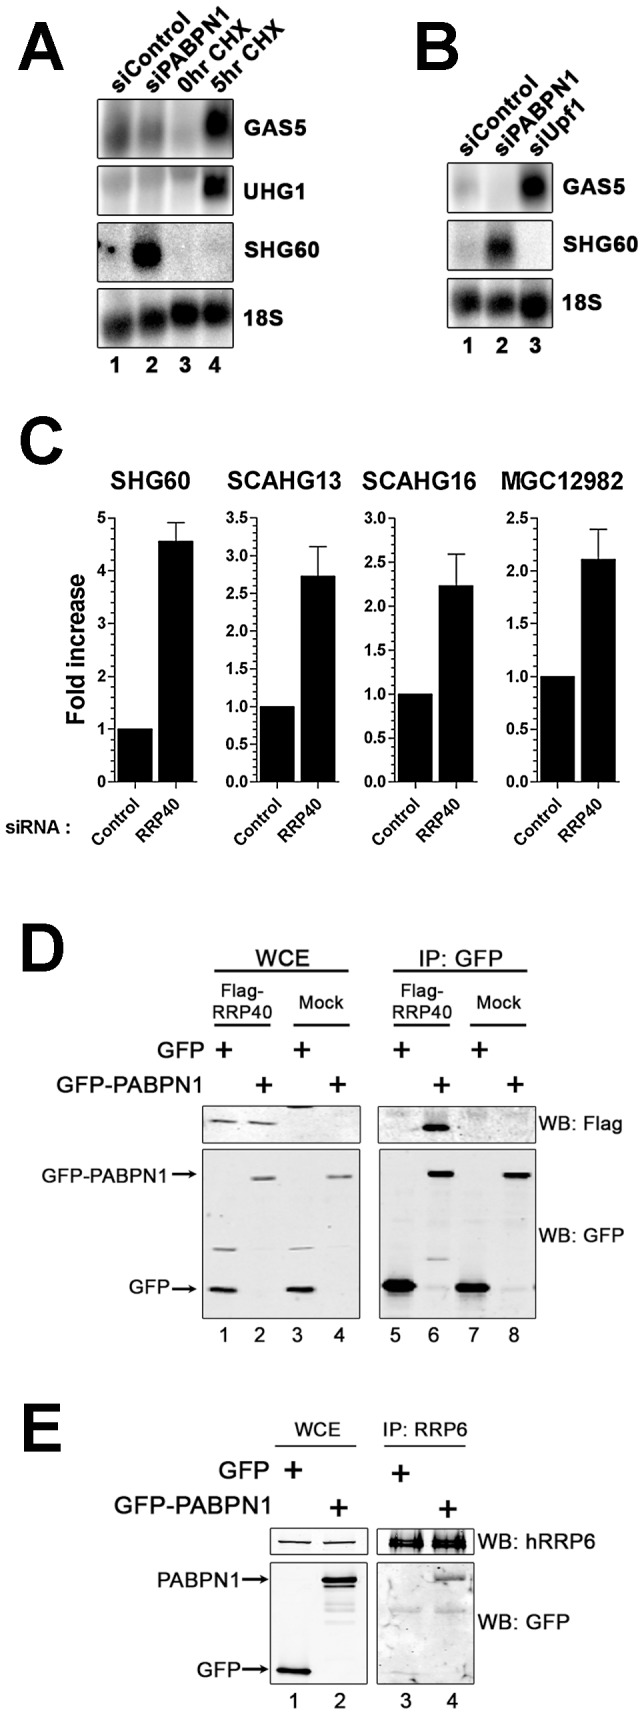
The RNA exosome, but not nonsense-mediated decay, contributes to PABPN1–dependent lncRNA decay.(A) Northern blot analysis of RNA prepared from untreated (lane 3) and cycloheximide-treated (lane 4; 20 µg/ml) HEK293T cells, as well as from cells treated with PABPN1–specific (lane 2) and control (lane 1) siRNAs. The blot was probed for the GAS5, UHG1, and SHG60 noncoding transcripts. The 18S rRNA was used as a loading control. (B) Northern analysis of RNA prepared from cells treated with control (lane 1), PABPN1–specific (lane 2), and UPF1-specific (lane 3) siRNAs. The blot was probed for the GAS5, SHG60, and 18S RNAs. (C) Quantitative RT-PCR analysis of RNA prepared from HeLa cells treated with control and hRRP40-specific siRNAs using sequence-specific primers to the indicated genes. Fold increases are relative to control siRNA and normalized to GAPDH mRNA. The data and error bars represent the average and standard deviation from at least three independent experiments. (D) Western analysis of whole cell extract (WCE; lanes 1–4) and GFP immunoprecipiates (IP; lanes 5–8) prepared from HEK293T cells that stably express GFP (lanes 1, 3, 5, and 7) or GFP-PABPN1 (lanes 2, 4, 6, and 8) and that were previously transfected with the empty vector (lanes 3–4 and 7–8) or a construct that expressed a Flag-tagged version of the hRRP40 (lanes 1–2 and 5–6). Western analysis was performed using antibodies specific to Flag (upper panel) and GFP (bottom panel). (E) Western analysis of whole cell extract (WCE; lanes 1–2) and hRRP6 immunoprecipiates (IP; lanes 3–4) prepared from HEK293T cells that stably express GFP (lanes 1 and 3) and GFP-PABPN1 (lanes 2 and 4). Western analysis was performed using antibodies specific to endogenous hRRP6 (upper panel) and GFP (bottom panel).